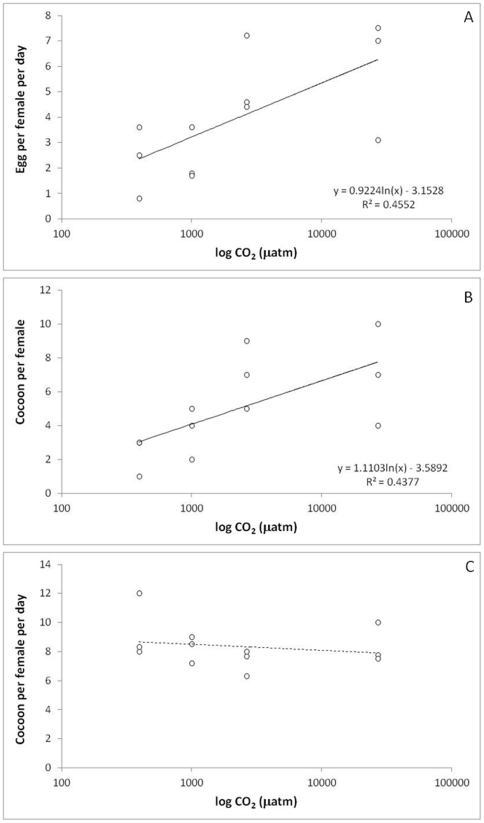
Impact of a range of pCO2 on: A. number of eggs produced per female; B. number of eggs per cocoon; C. number of cocoon produced per female (experiment 4).The number of eggs produced per female was 3 times higher in high compared to low pCO2 (27 k vs 0.4 k µatm) and a significant logarithmic relationship was observed between the two parameters (F = 8.36, p<0.016; Figure 3A). This was the consequence of an increased number of cocoon produced per female (significant logarithmic relationship, F = 7.79, p<0.02; Figure 3B) with no effect on the number of eggs per cocoon (non significant logarithmic relationship, F = 0.43, p<0.53; Figure 3C).